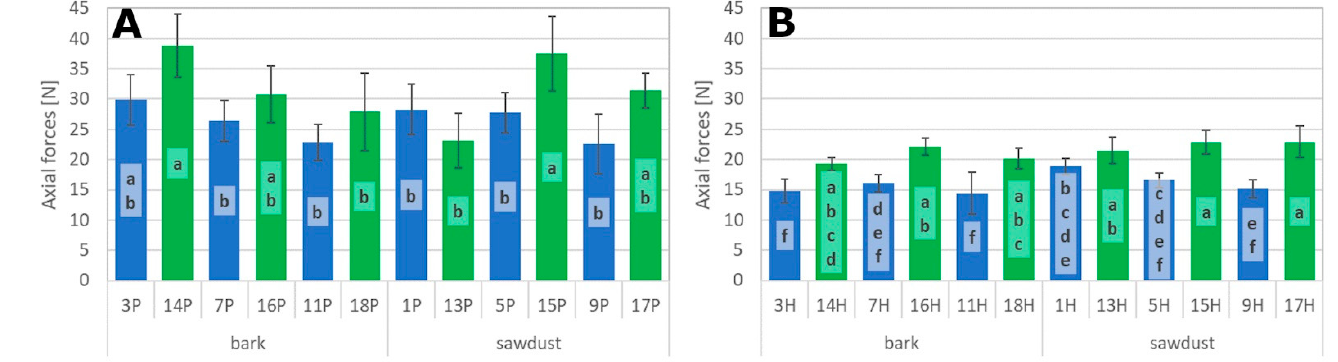
Figure 5. Values of axial forces during drilling: ( A ) PLA-based composites with (green) and without (blue) addition of CaO; ( B ) HDPE-based composites with (green) and without (blue) addition of MAHPE (a, b, c, d, e, f—homogeneous groups by Tukey’s test). Table 6. Analysis of variance for selected factors and interactions between the factors influencing the axial force during drilling PLA-based composite with addition of CaO.